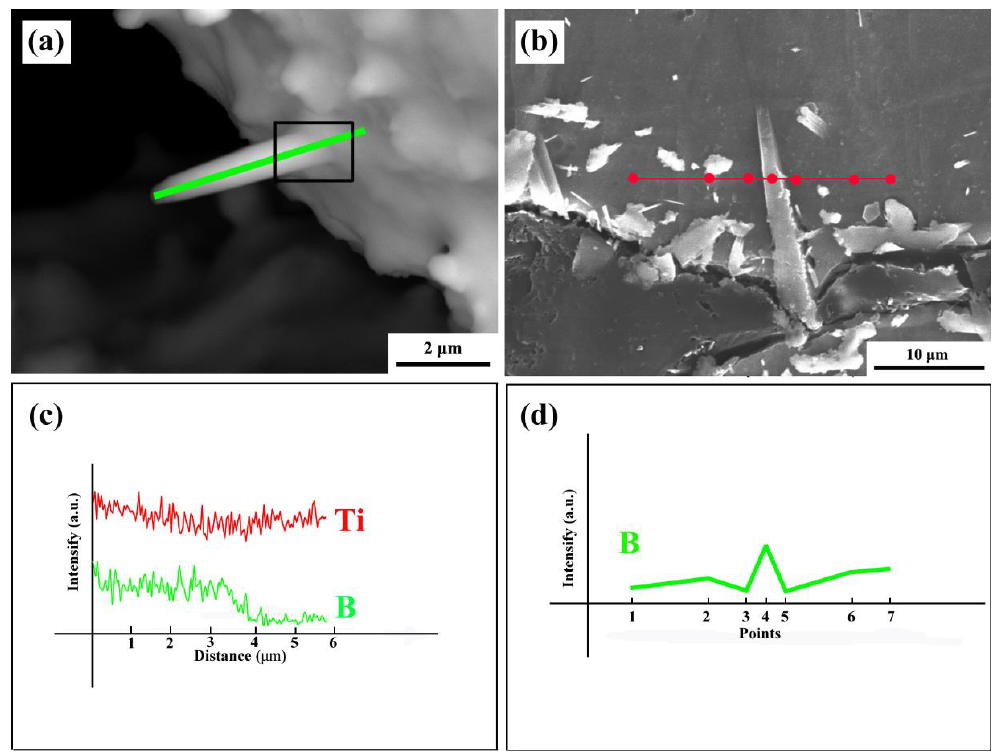
Figure 3. ( a ) SEM of sticking out needled TiBw, ( b ) SEM and of TiBw pinned in Ti matrix, ( c ) line scanning results of a, ( d ) point scanning results of b.